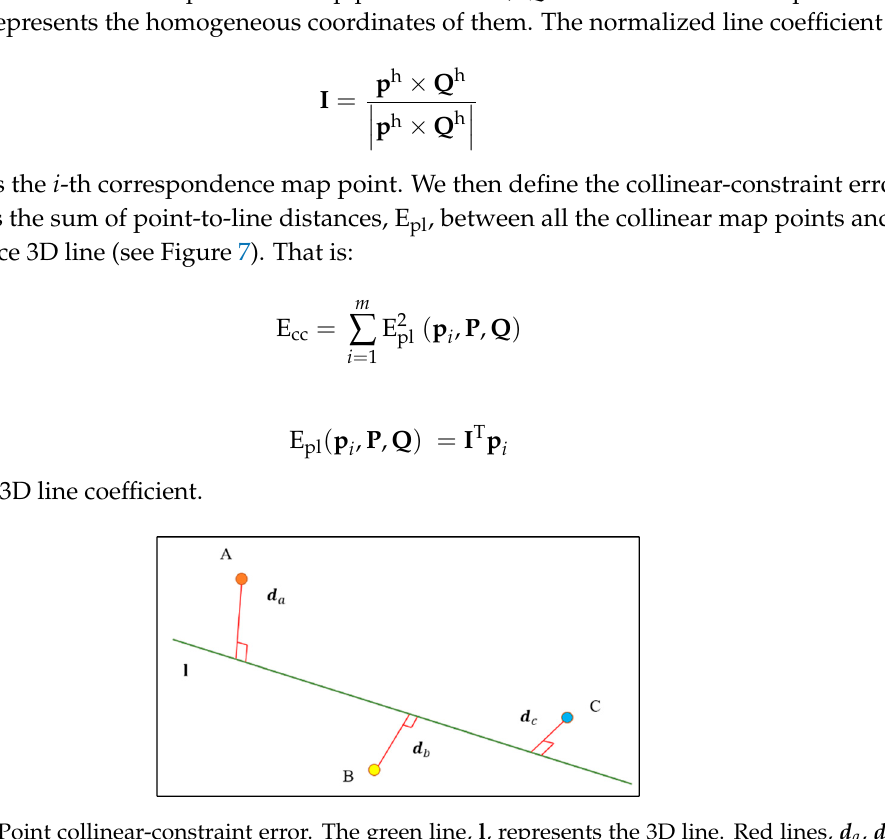
Figure 7. Point collinear-constraint error. The green line, l , represents the 3D line. Red lines, d a , d b , and d c , are point-to-line distances between the 3D line and its corresponding map points. The point collinear-constraint error of a 3D line is the sum of point-to-line distances between the 3D line and all its corresponding collinear map points.